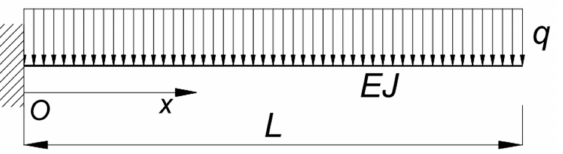
Figure 5. Cantilever beam subjected to uniformly distributed transverse